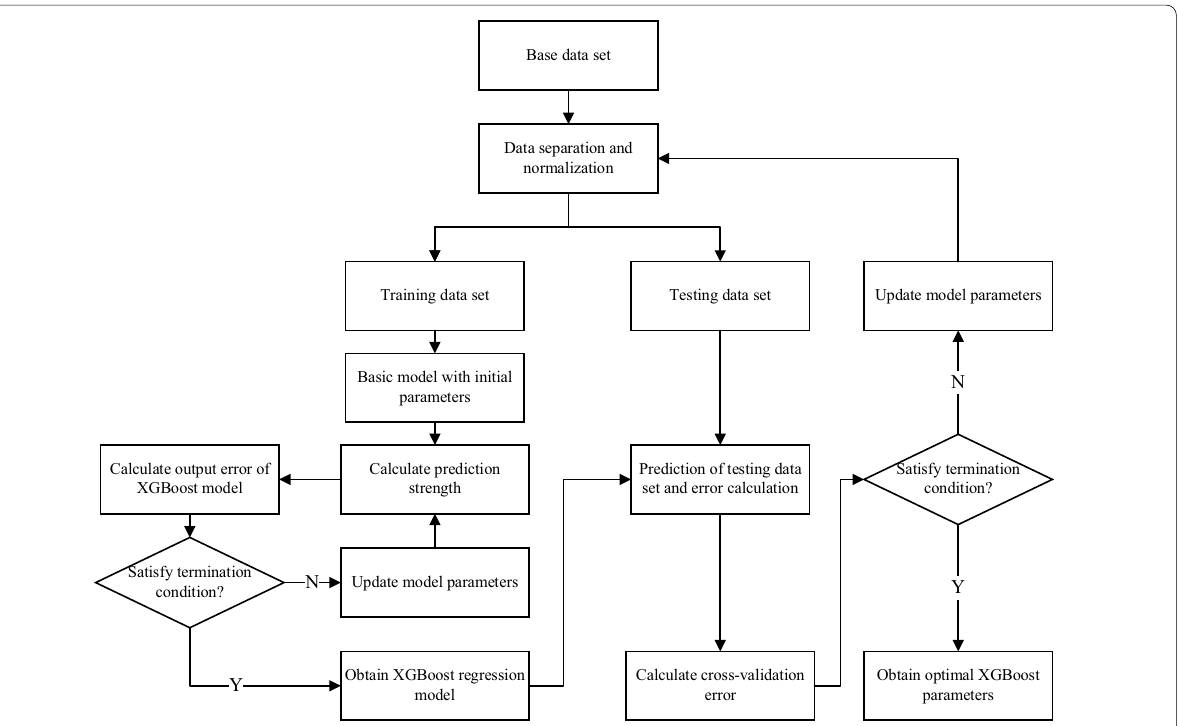
the prediction error was calculated to see whether the prediction accuracy is guaranteed. (4) Cross-validation. Cross-validation is a model assessment technique and generally used to evalu- ate the prediction performance of a machine learn- ing algorithm for new data sets that it has not been trained with. And 100 rounds of cross-validation were performed by using different seed parameters to acquire different random assignments of train-